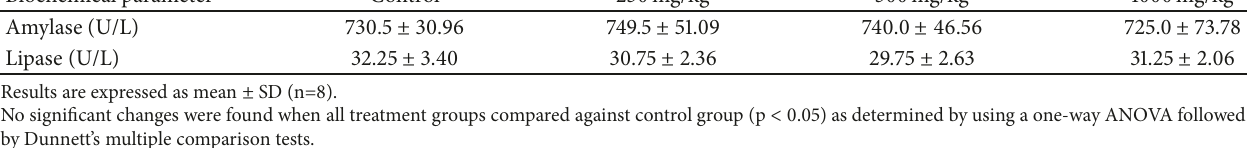
Table 8: The effects of different concentrations of pomelo methanolic extracts on pancreatic function.